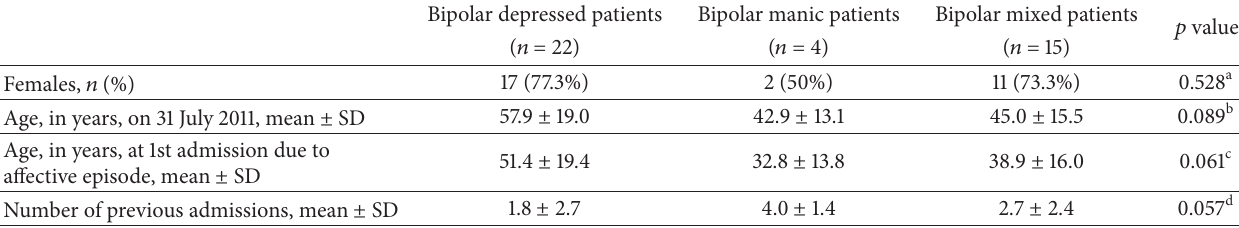
Table 1: Demographic and clinical characteristics of the sample of patients ( 𝑛 = 41